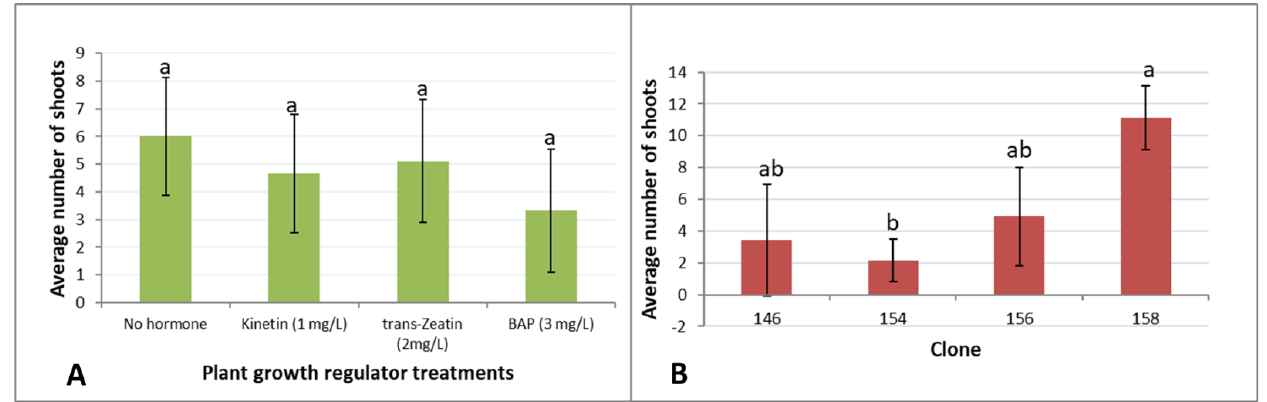
Figure 3. Xerophyllum asphodeloides shoot multiplication on ½ MS medium without PGRs after five weeks. Standard errors are shown for each treatment. Treatments with same letter are not statistically different by multiple range test at p = 0.05. ( A ) Effect of cytokinins averaged for the four clones. ( B ) Effect of clone averaged for the four media tested.